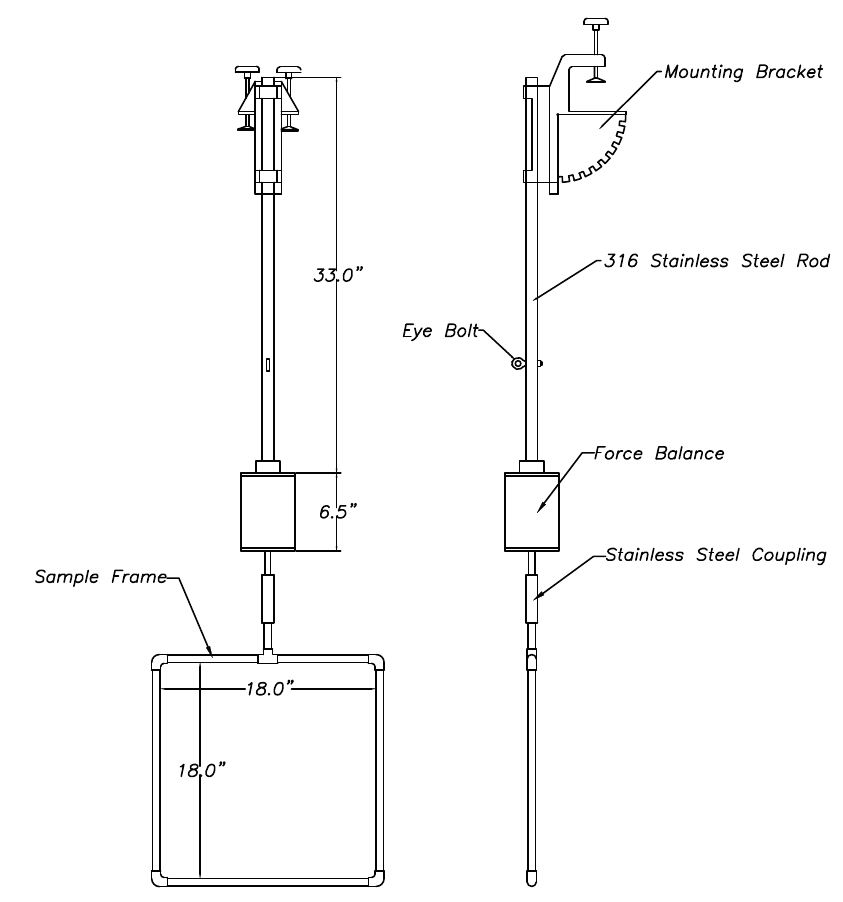
Figure 10. Force balance